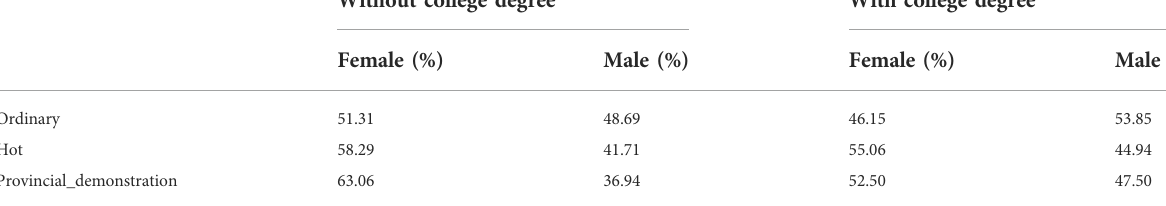
TABLE 5 Gender differences in the percentage of picking up